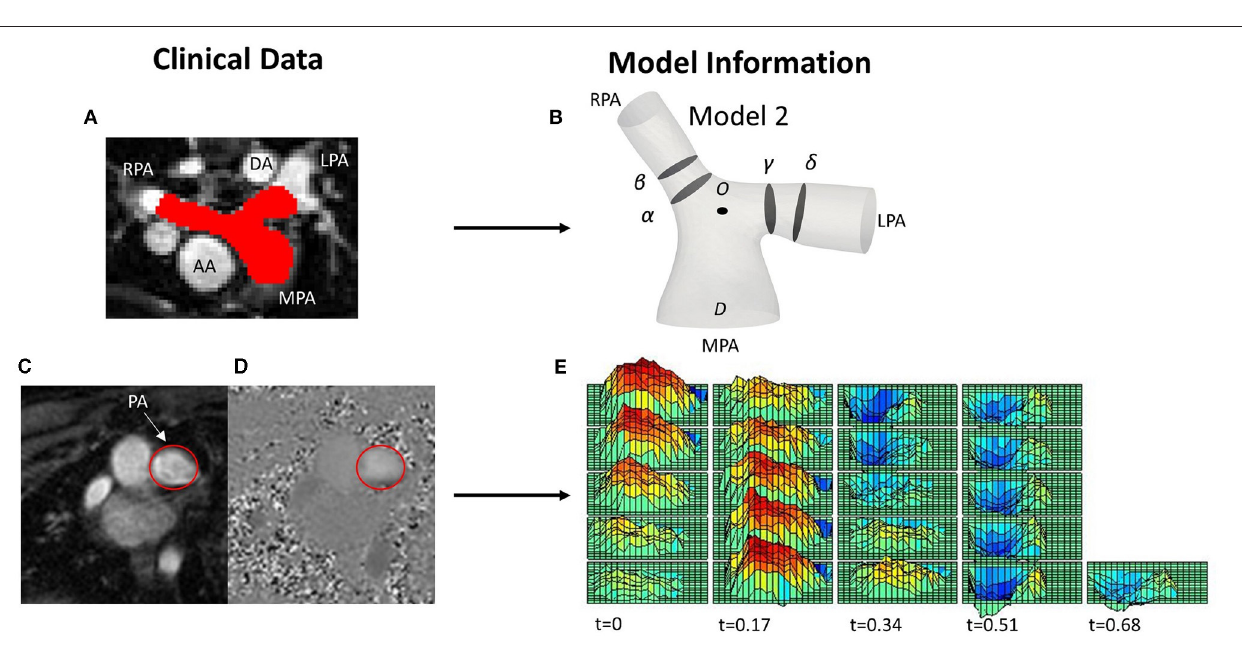
FIGURE 1 | (A) MRI image with red color depicting the pulmonary arteries (PAs), including the main (MPA), left (LPA) and right pulmonary artery (RPA), and showing the descending (DA) and ascending aorta (AA) relevant to the PAs, for reference. (B) One of the reconstructed patient-specific models (Model 2), with slices ( α ) and ( β ) over the RPA, and ( γ ) and ( δ ) over the LPA shown in the model. (C,D) PC-MRI data from the same patient used for the extraction of the velocity profile at the MPA root, with the MPA encircled in red; (C) magnitude and (D) phase contrast (PC-MRI) image. (E) 3D-velocity profile extracted from PC-MRI data displaying the variation of the velocity both in space and time over a cardiac